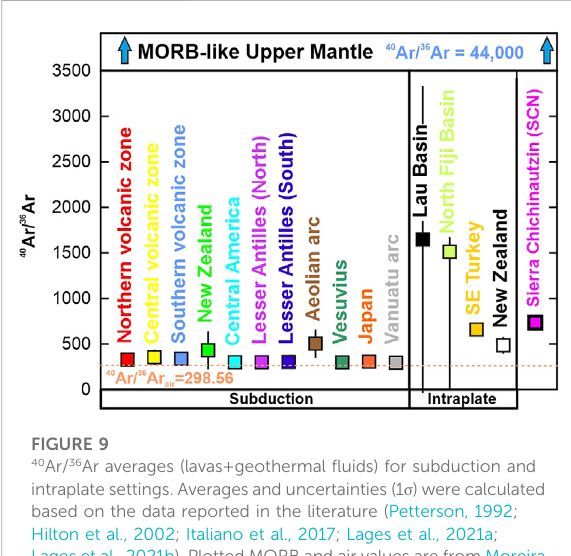
FIGURE 9 40 Ar/ 36 Ar averages (lavas+geothermal fl uids) for subduction and intraplate settings. Averages and uncertainties (1 σ )were calculated based on the data reported in the literature (Petterson, 1992; Hilton et al., 2002; Italiano et al., 2017; Lages et al., 2021a; Lages et al., 2021b). Plotted MORB and air values are from Moreira et al. (1998) and Lee et al.